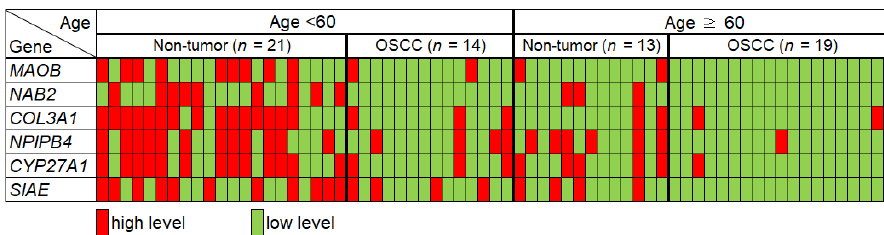
Figure 3. Direct comparison of candidate mRNA levels according to age in the two groups together. The subjects representing the ΔΔCt below non-tumor group’s average ΔΔCt−S.D. are marked as “low level” mRNA, which is represented as green color. The subjects who showed higher ΔΔCt than this value were marked as “high level” expression, which is marked with red color. The cut-off of ΔΔCt for cancer diagnosis (low level) of each mRNA under-60 group is 1.66 for MAOB, 1.65 for NAB2, 1.02 for COL3A1, 1.27 for NPIPB4, 1.22 for CYP27A1, and 0.93 for SIAE.